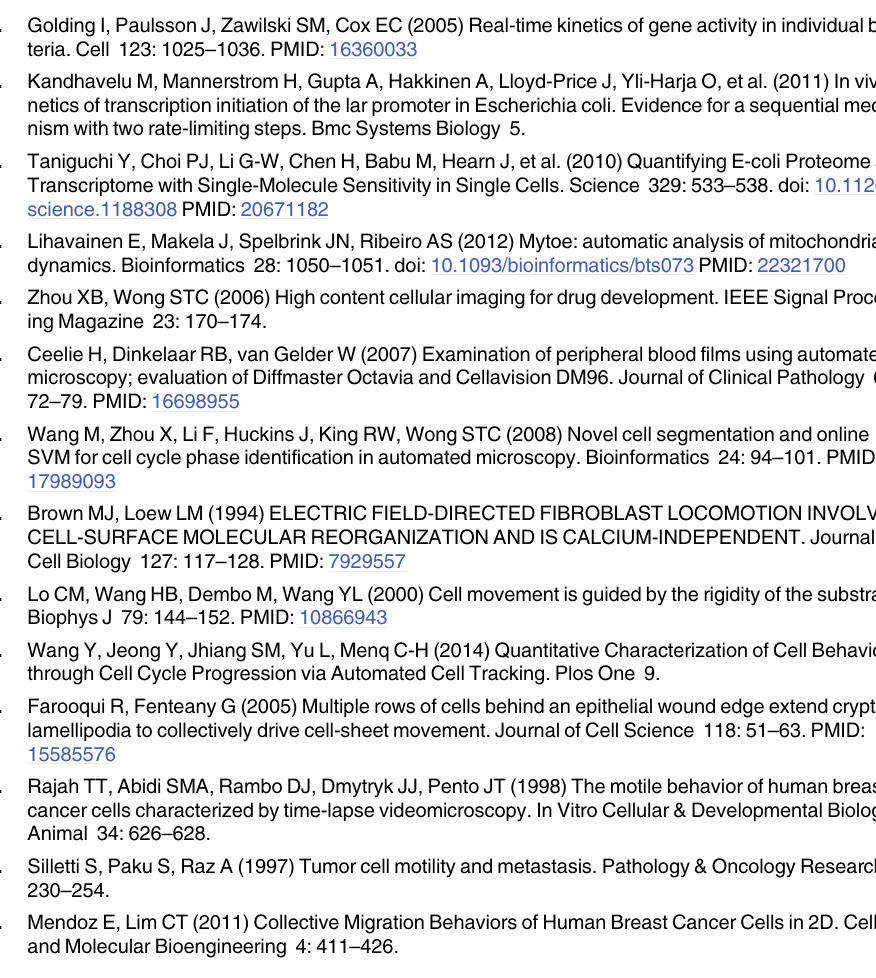
S1 Fig. Figure of Euclidean Distance Transform for Fig 5B. (TIF) S1 File. Numerical Solution to the active contour model. The file shows details procedure for numerical solution to the edge based active contour model of Eqs (3) and (4). (DOC) S1 Zip File. Matlab tool box. The developed MATLAB tool box for image segmentation using the method proposed in this paper. The raw images shown in Figs 11 and 12 are also included in the